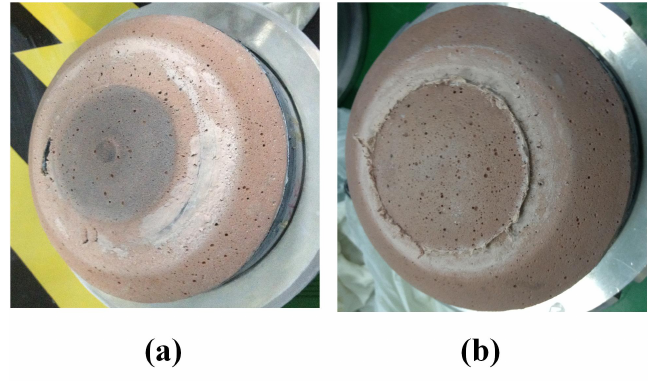
Figure 7. Two different SR bonnet tools with the damaged polyurethane pad. ( a ) damaged SR bonnet tool with the embedded material of stainless steel sheet and ( b ) damaged SR bonnet tool with the embedded material of steel